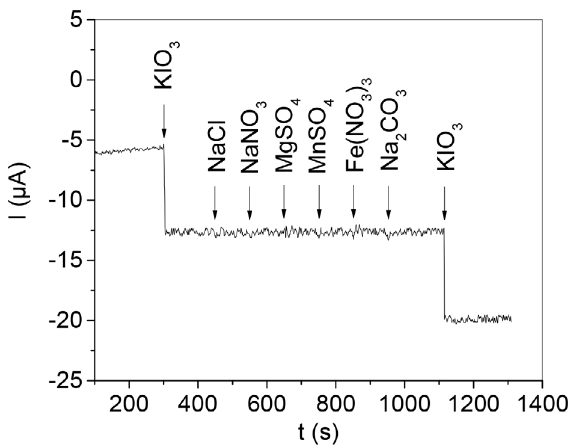
Fig. 6. Amperometric I-t curve of modified electrode RuOHCF/GC for the determination of 0.1 mM KIO 3 in the presence of 3.3 mM of different interfering species added one by one with an interval of 100 s to PBS (pH 1.0) at an applied potential of –0.1 V.